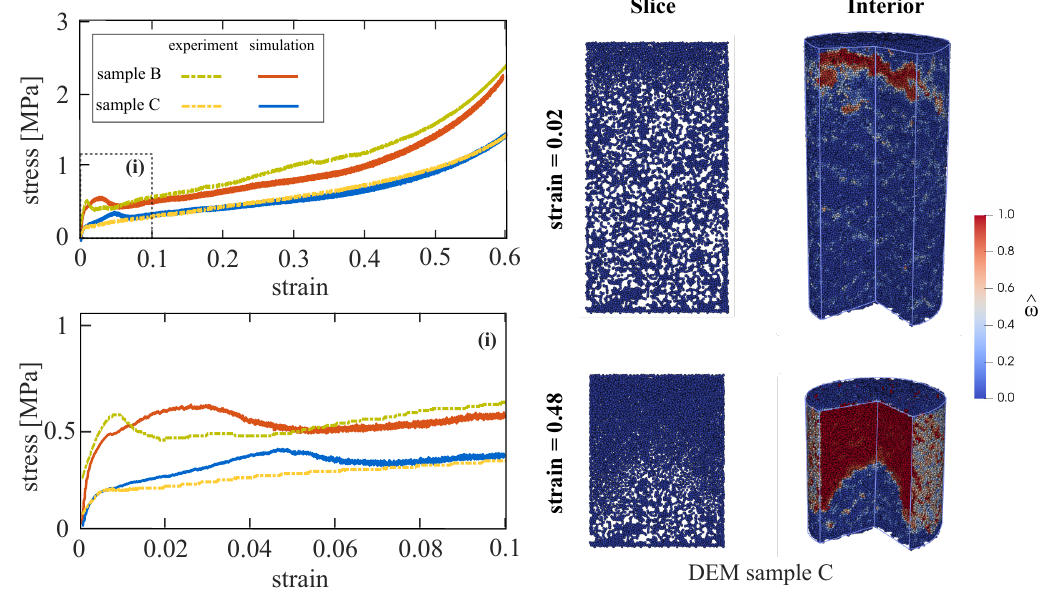
Figure 10. ( Left ): Calibration step 3 and model validation: Results from DEM simulations of confined compression tests on samples B and C and comparisons with test results. The experimentally observed behavior of mix B (green dotted line) was used for the calibration of the model plasticity parameters (red lines). The numerical results for sample C (blue lines) are predictions and must be validated against the experimental results (yellow dotted lines). ( Right ): Distribution of damage in the cross section and interior of specimen predicted by the DEM model for sample C under confined compression in two stages of compressive